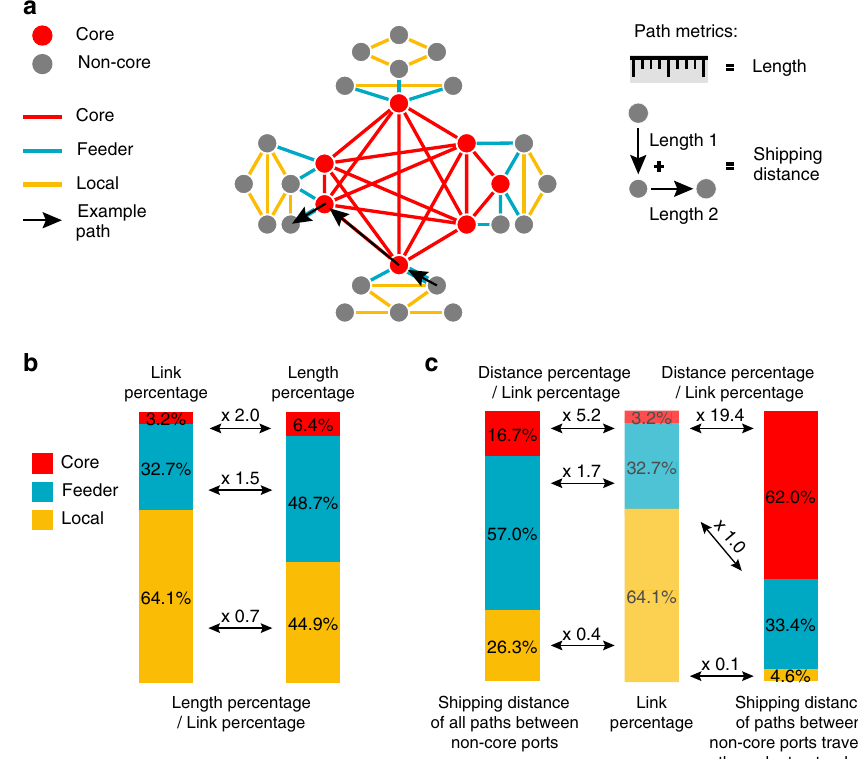
Fig. 8 Statistics of the core, feeder and local connections. a Schematic illustration of path metrics; the geographical length of an inter-port connection is measured as the real nautical distance (https://www.searates.com/services/distances-time/) between the two ports, and shipping distance of any port pair is the sum of geographical length of edges along the shortest path. b Ratios of length percentage to link percentage for core connections, feeder connections and local connections, respectively. c Percentages of core connections, feeder connections and local connections in the total shipping distance of all shortest paths between non-core ports (left bar), and of shortest paths between non-core ports which travel through the structural core (right bar). To better understand those three types of connections related with the structural-core organization of the GLSN, one is encouraged to refer to the hub- and-spoke service network con fi guration (Hu and Zhu) 13 , which is widely adopted by world liner shipping carriers in practice. The hub-and-spoke con fi guration is illustrated in the Supplementary Fig. 5. In addition, we estimated the physical length of an inter-port connection as the great-circle distance based on ports ’ geographical locations of latitude and longitude, and then repeated the analysis. We found all the results reported here remain almost invariant (Supplementary Note 8).